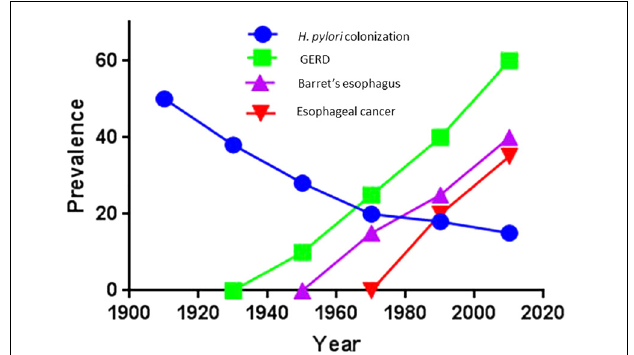
FIGURE 2 | Current trends in esophageal diseases in relation to the gradual decline in H. pylori colonization specific for Caucasian populations in developed countries (Hunt and Yaghoobi, 2017).